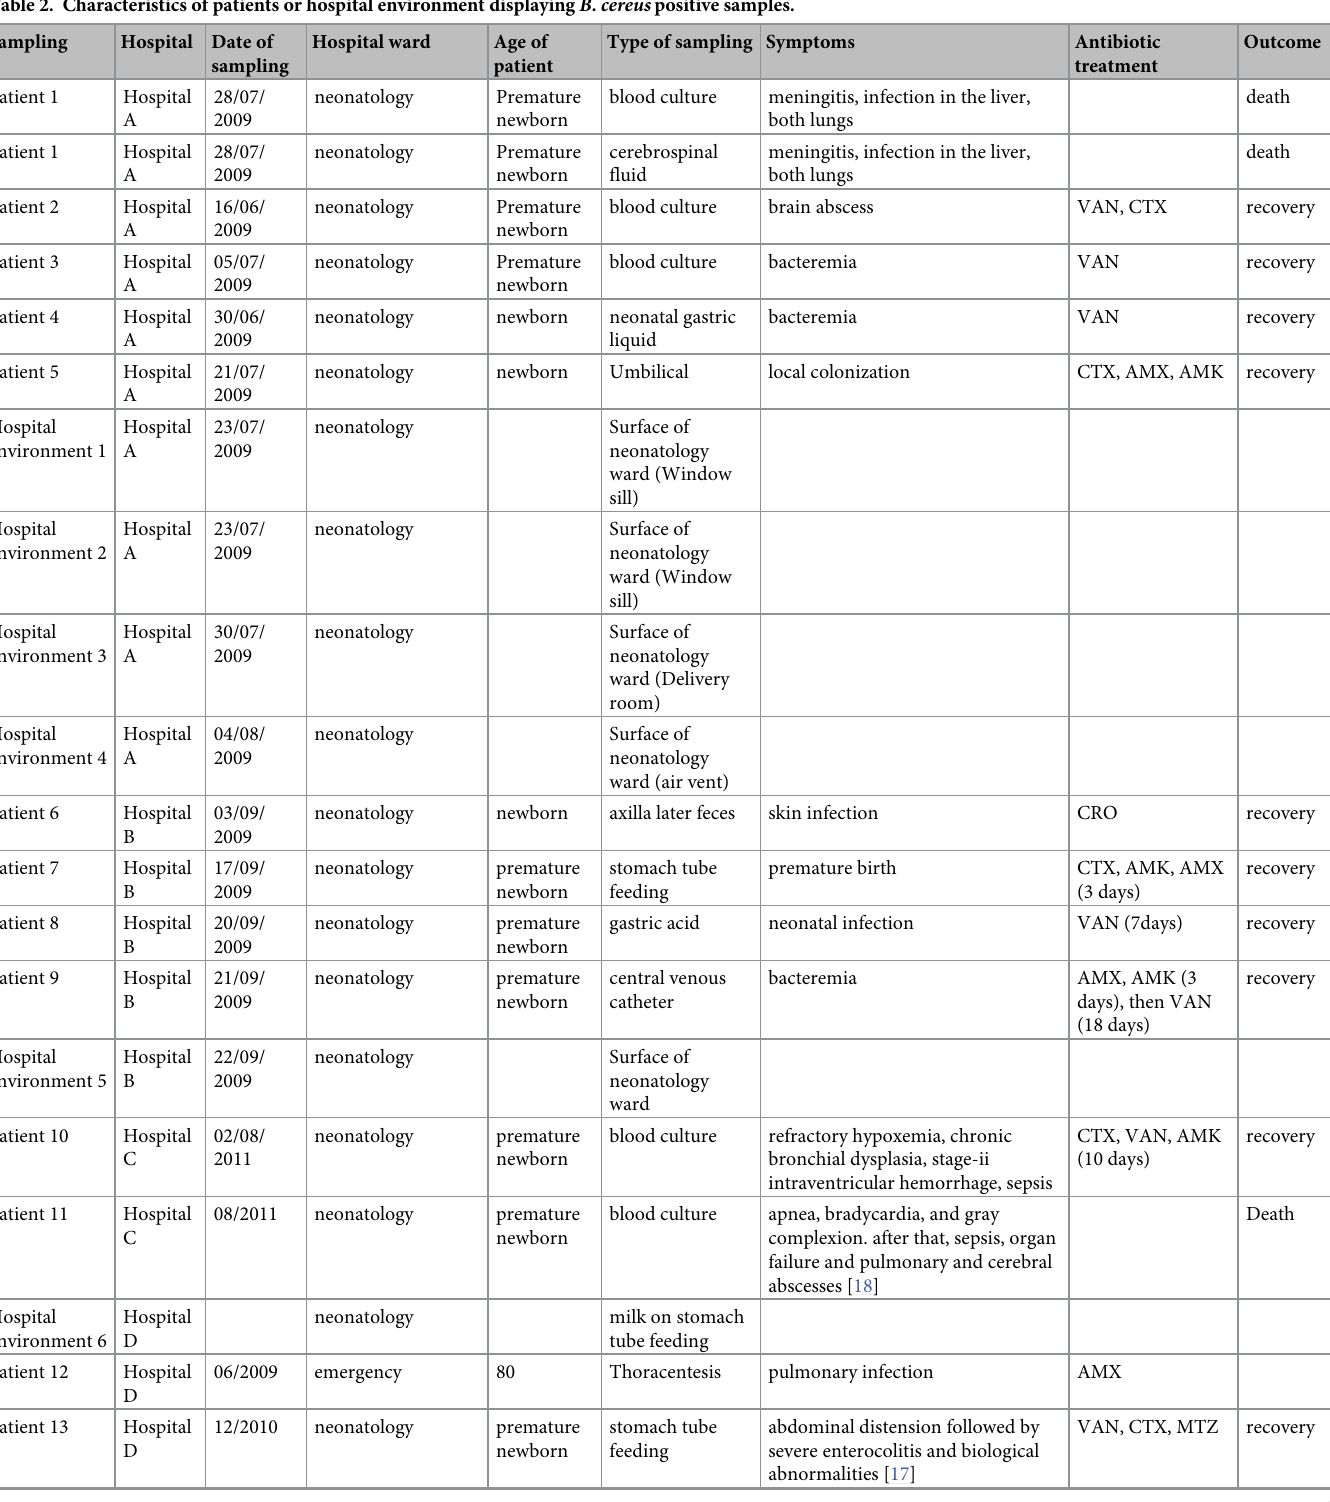
Table 2. Characteristics of patients or hospital environment displaying B . cereus positive samples.